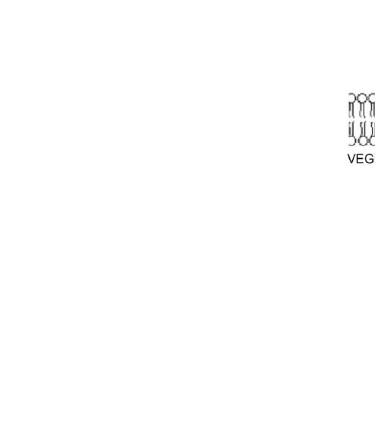
FIGURE 3 Molecular pathways of cabozantinib [image from Yu et al.